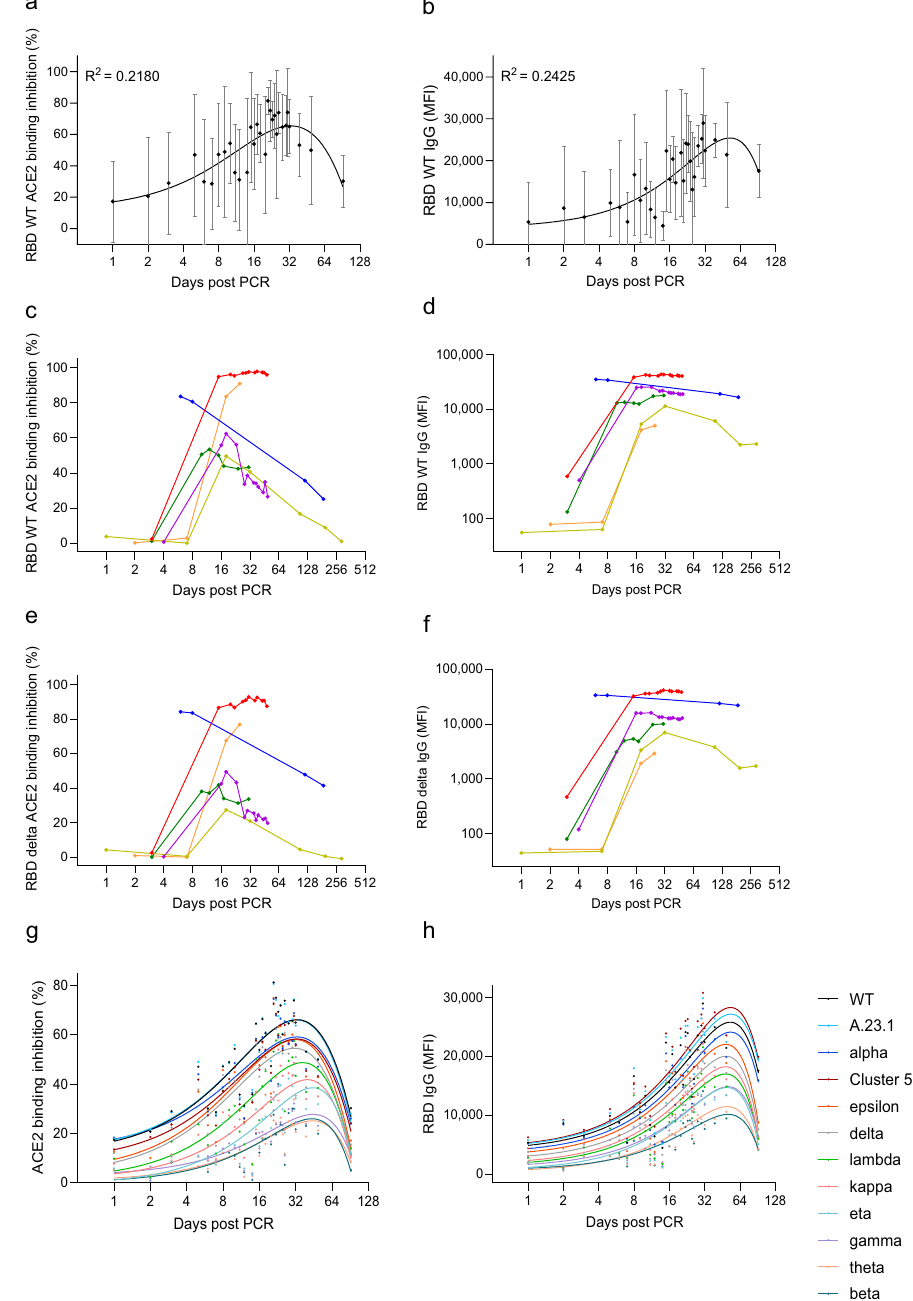
Figure 5. Longitudinal analysis of ACE2 binding inhibition and anti-RBD IgG levels in COVID-19 patients. Mean ACE2 binding inhibition (%) and IgG responses (MFI) for wild-type RBD against time post positive PCR test for samples (n = 149) taken from 1 to 92 days post PCR are shown ( a , b ). Black dots indicate mean responses with standard deviation indicated by the error bars. The same analysis is then shown for longitudinal samples of selected donors (n = 6) for wild-type ( c , d ) and RBD delta ( e , f ). For all RBD mutants, mean ACE2 binding inhibition (%) and mean IgG responses (MFI) 1 to 92 days post PCR are shown ( g , h ). Each variant is illustrated by a different color according to the figure